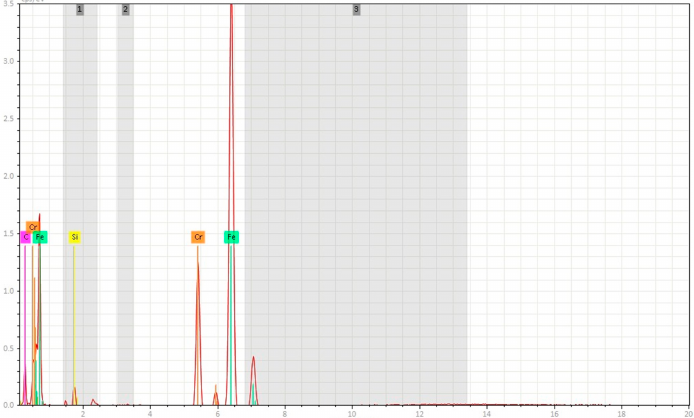
Figure 10. EDS ‐ SEM analysis composition of the non ‐ used drills.